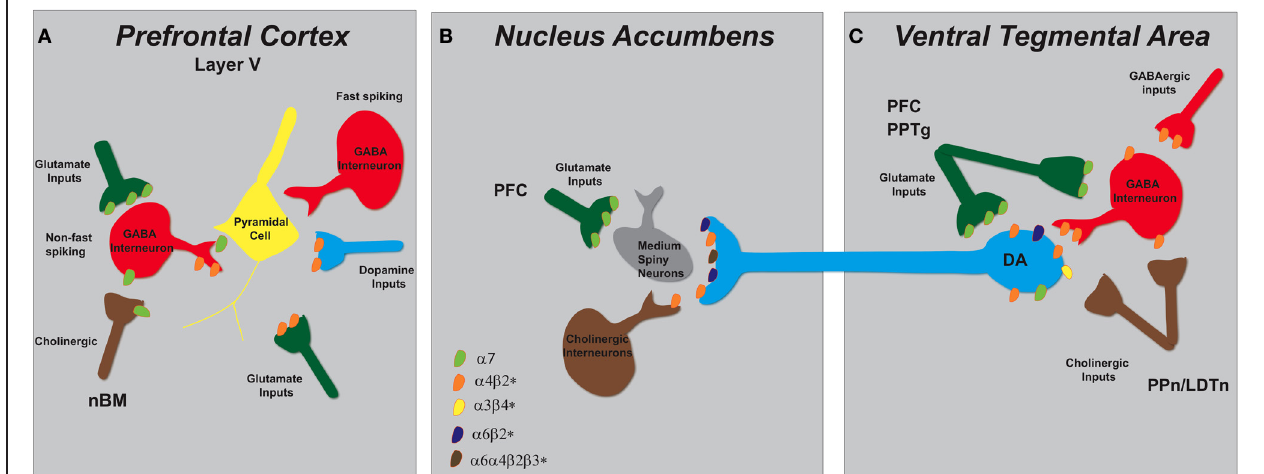
and α 6 α 4 β 2 ∗ ) expressed on DAergic terminals from the VTA mediate DA release based on the neuronal activity firing rate. A small population of tonically active cholinergic interneurons ( ∼ 2%) is synchronized with DA cell firing. Glutamatergic inputs from the PFC endow α 7 nAChRs. (C) The VTA receives cholinergic innervation from the pedunculopontine (PPn) and laterodorsal tegmental nuclei (LDTn). In addition to the nAChRs localized on DA cell bodies, DAergic cell firing is modulated by α 4 β 2 ∗ (and possibly α 7) nAChRs expressed on GABAergic interneurons and excitatory glutamatergic afferents from the PFC and the